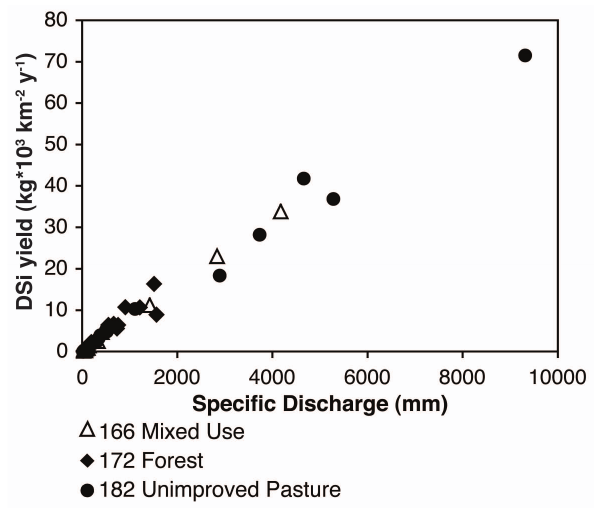
Fig. 6. Dissolved silica yields for discreet sampling events from WS 166, WS 172, and WS 182 plotted with instantaneous annual specific discharge